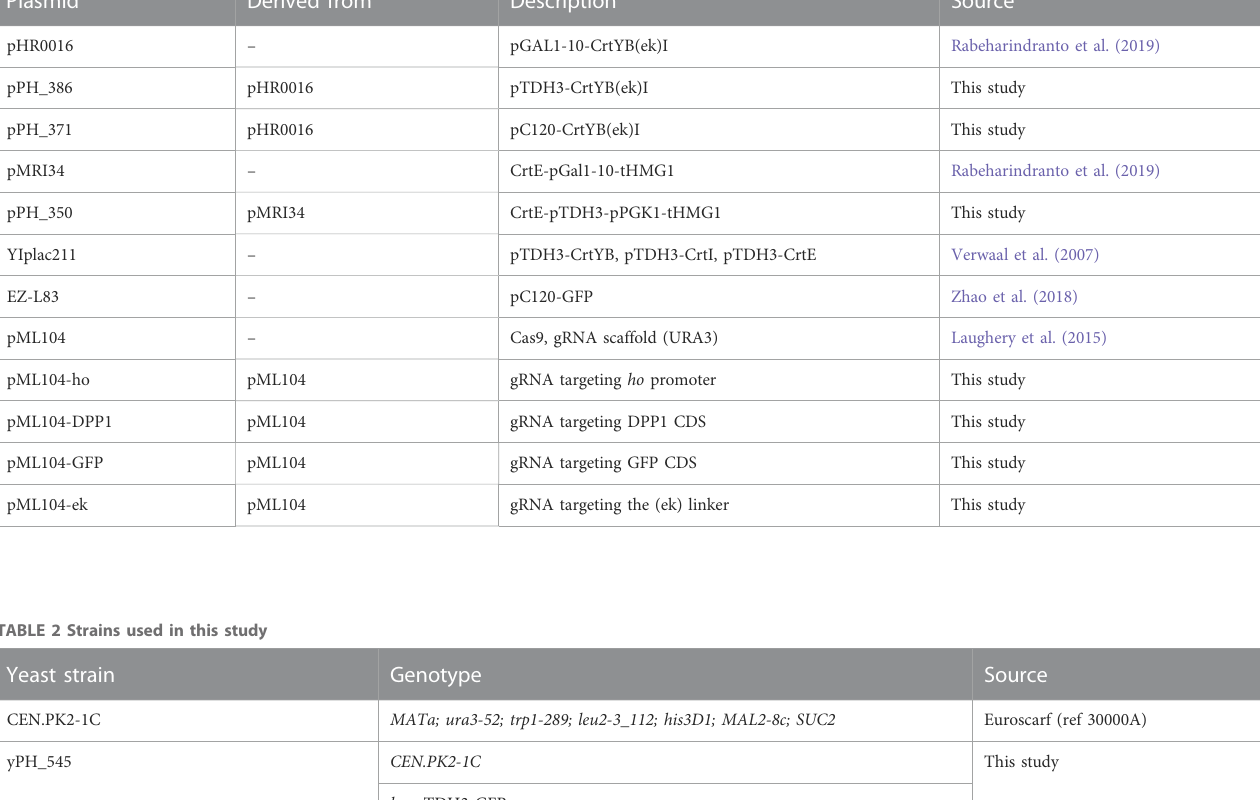
Table 2. The GFP optogenetic strain OPTO-EXP originated from (Zhao et al., 2018). Using the CEN.PK2-1C background, pPGK1- TABLE 1 Plasmids used in this study.